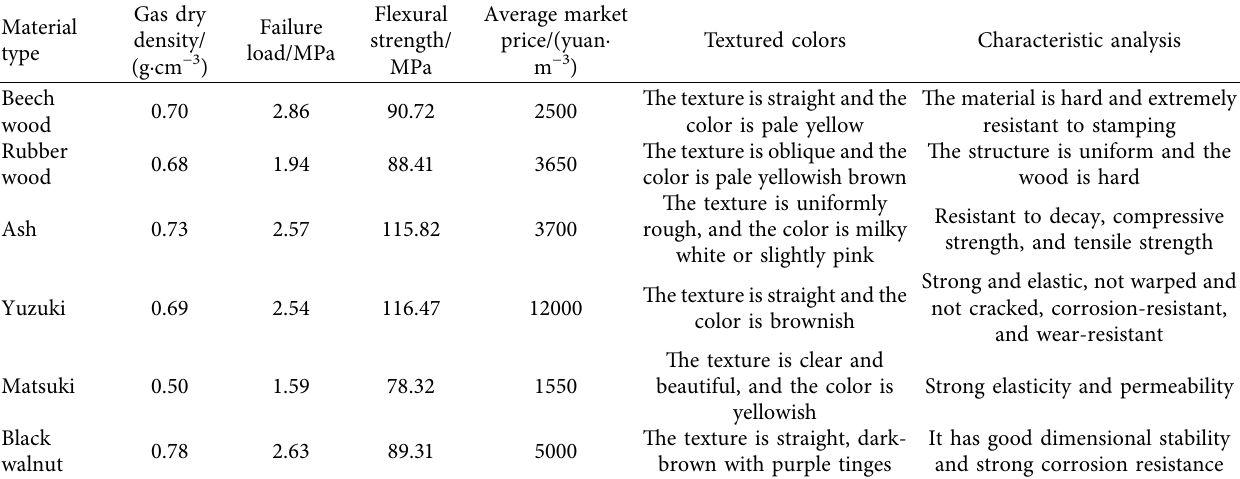
Table 3: Comparison of mechanical properties, texture, and color of several commonly used woods.